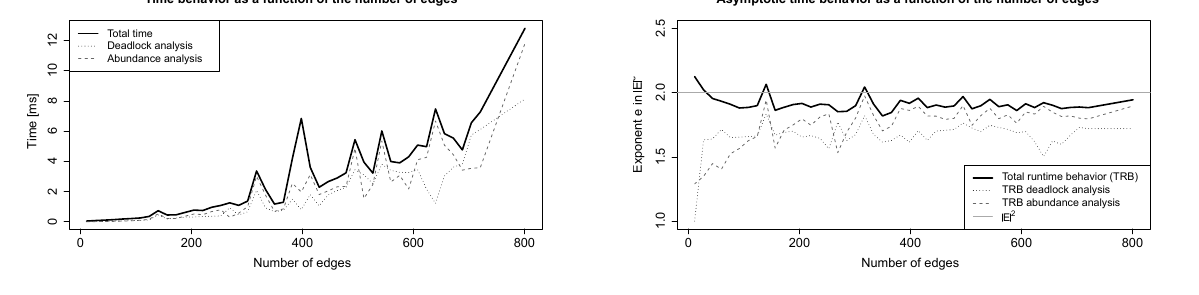
Figure 33. Runtime as a function of the number of edges